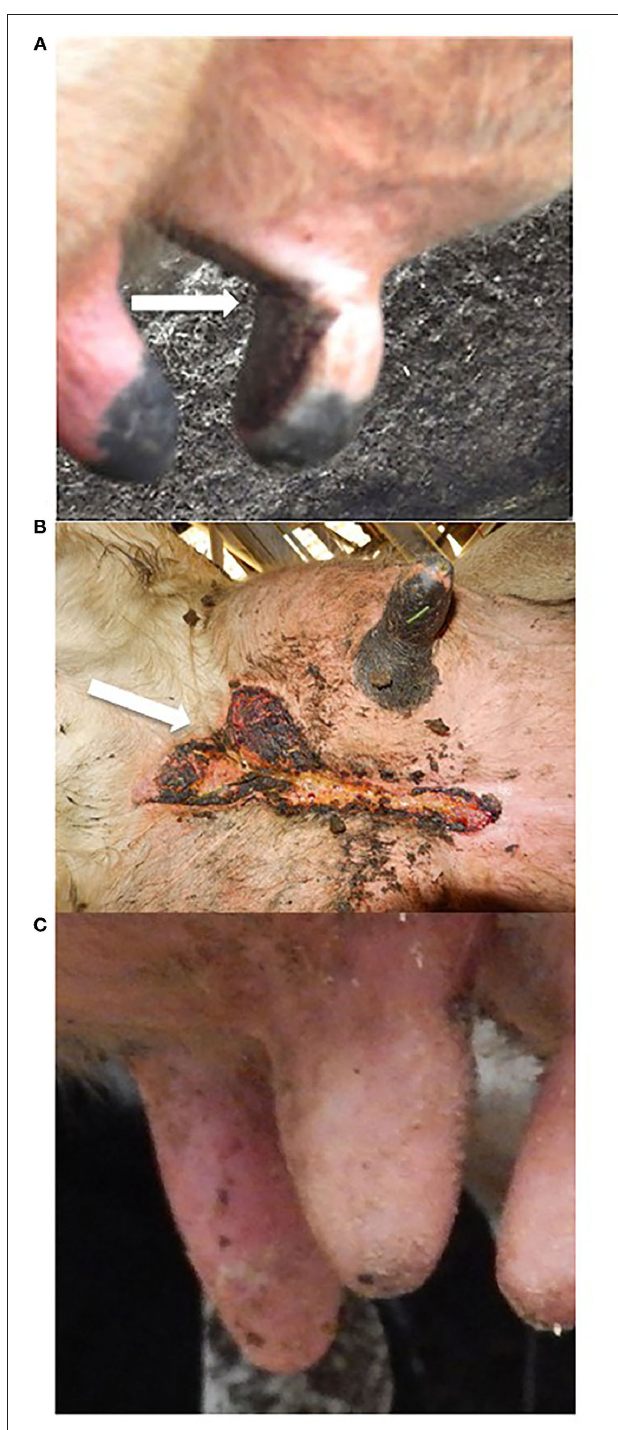
FIGURE 4 | Udder lesions. (A) Photograph of a typical ischaemic teat necrosis (ITN) lesion with dark red to black, well-demarcated area of necrosis on the medial aspect of the teat extending to the udder indicated by the arrow. (B) Photograph of a typical udder cleft dermatitis (UCD) lesion affecting midline between the two halves of the udder and cranially to the cleft between the anterior udder and the abdomen indicated by the arrow. (C) Photograph of chapped teats with rough, dry skin on over the entire